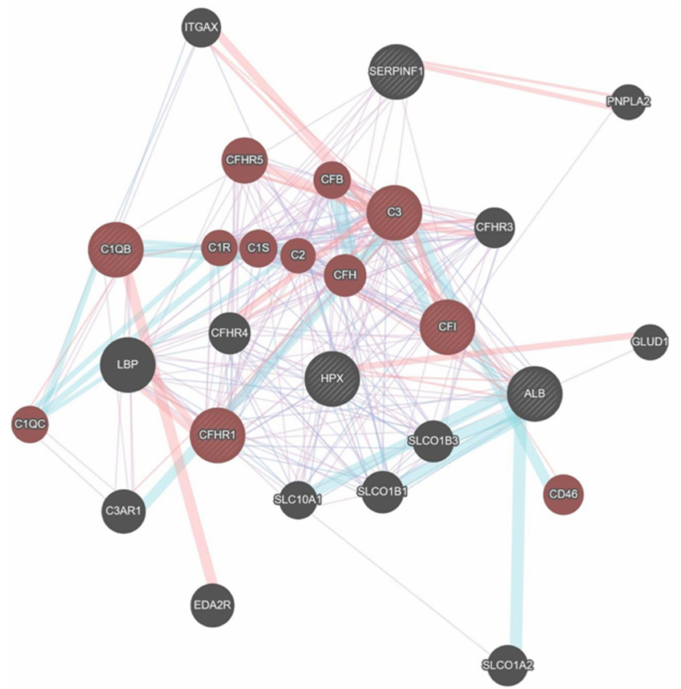
Figure 12. Bio-Informatical Network Analysis HH 60 vs.